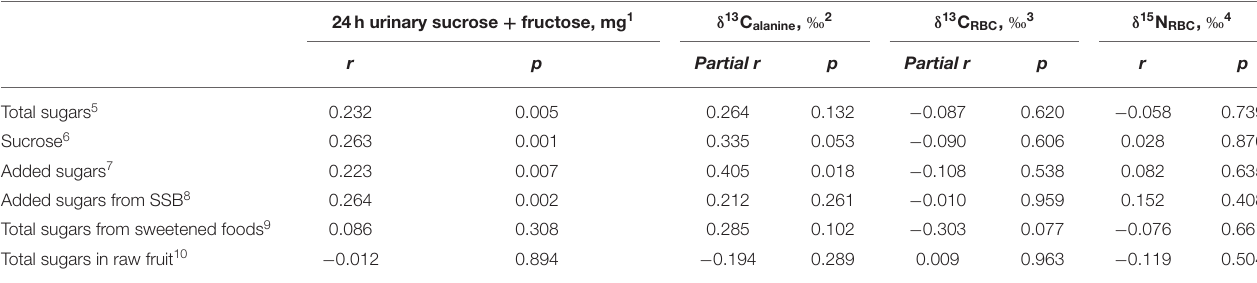
TABLE 3 | Correlation coefficients between dietary sugars intakes estimated by food frequency questionnaire (g/d) and biomarkers for sugars intake from spot urinesamples and red blood cells. 24h urinary sucrose + fructose, mg 1